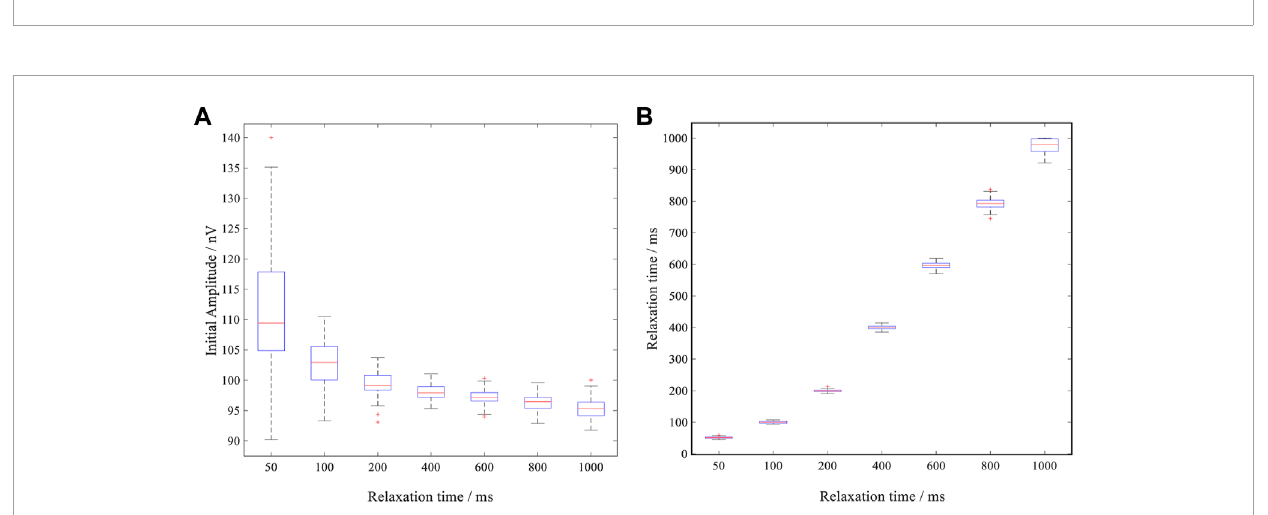
Frontiers in Earth Science